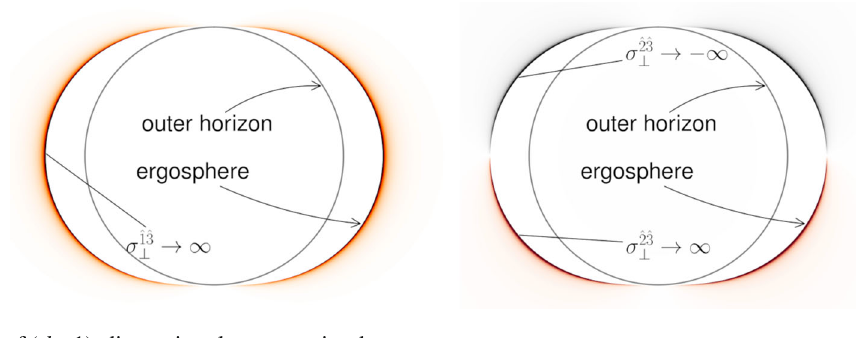
ˆ 1 ˆ 3 σ ˆ 2 ˆ 3 ⊥ and ⊥ : darker